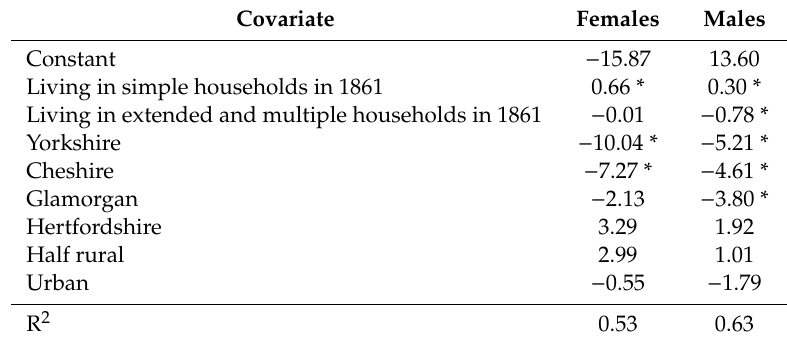
Table 3. Results of multiple regression analysis of percentages of those aged 60 years and over receiving payments under the New Poor Law in 1891 on the percentages of those aged 30–59 years in 1861 living in simple and extended / multiple households and control variables: 63 registration districts of England and Wales. Covariate Females Males Constant − 15.87 13.60 Living in simple households in 1861 0.66 * 0.30 * Living in extended and multiple households in 1861 − 0.01 − 0.78 * Yorkshire − 10.04 * − 5.21 * Cheshire − 7.27 * − 4.61 * Glamorgan − 2.13 − 3.80 * Hertfordshire 3.29 1.92 Half rural 2.99 1.01 Urban − 0.55 − 1.79 R 2 0.53